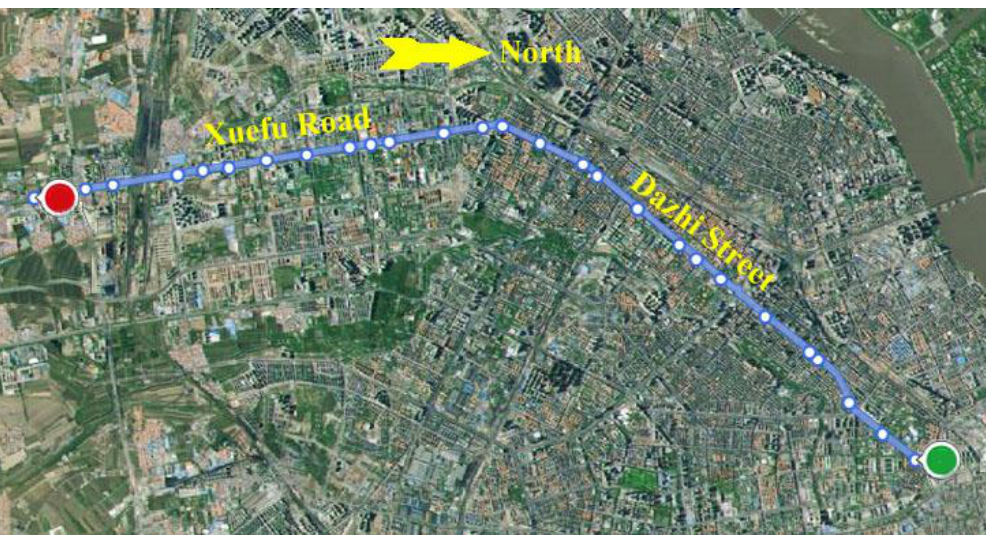
Figure 1. The route map of Line 104 in